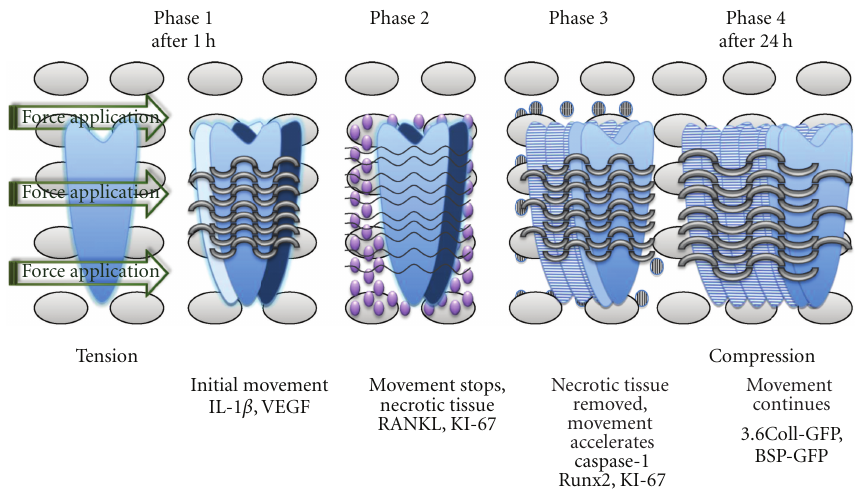
Figure 1: Phases of tooth movement associated with the application of orthodontic